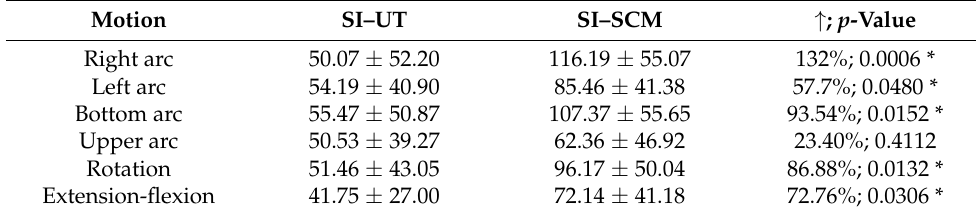
Table 3. Mean and standard deviation of symmetry indices calculated for upper trapezius (UT) and sternocleidomastoid (SCM) muscles, where ↑ denotes the percentage of positive difference in the symmetry index for SCM compared to that recorded for UT; * denotes statistically significant differences, p <